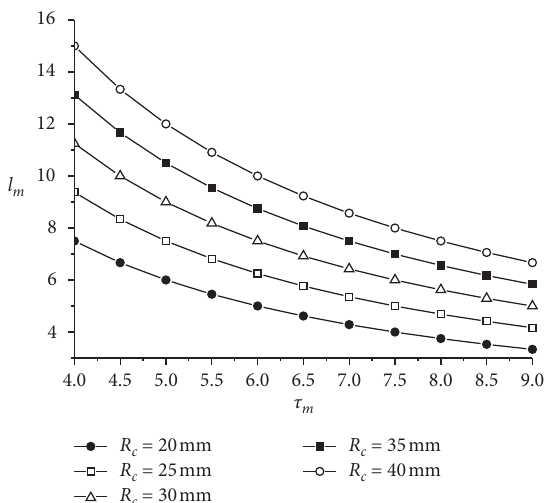
Figure 9: The relationship between τ